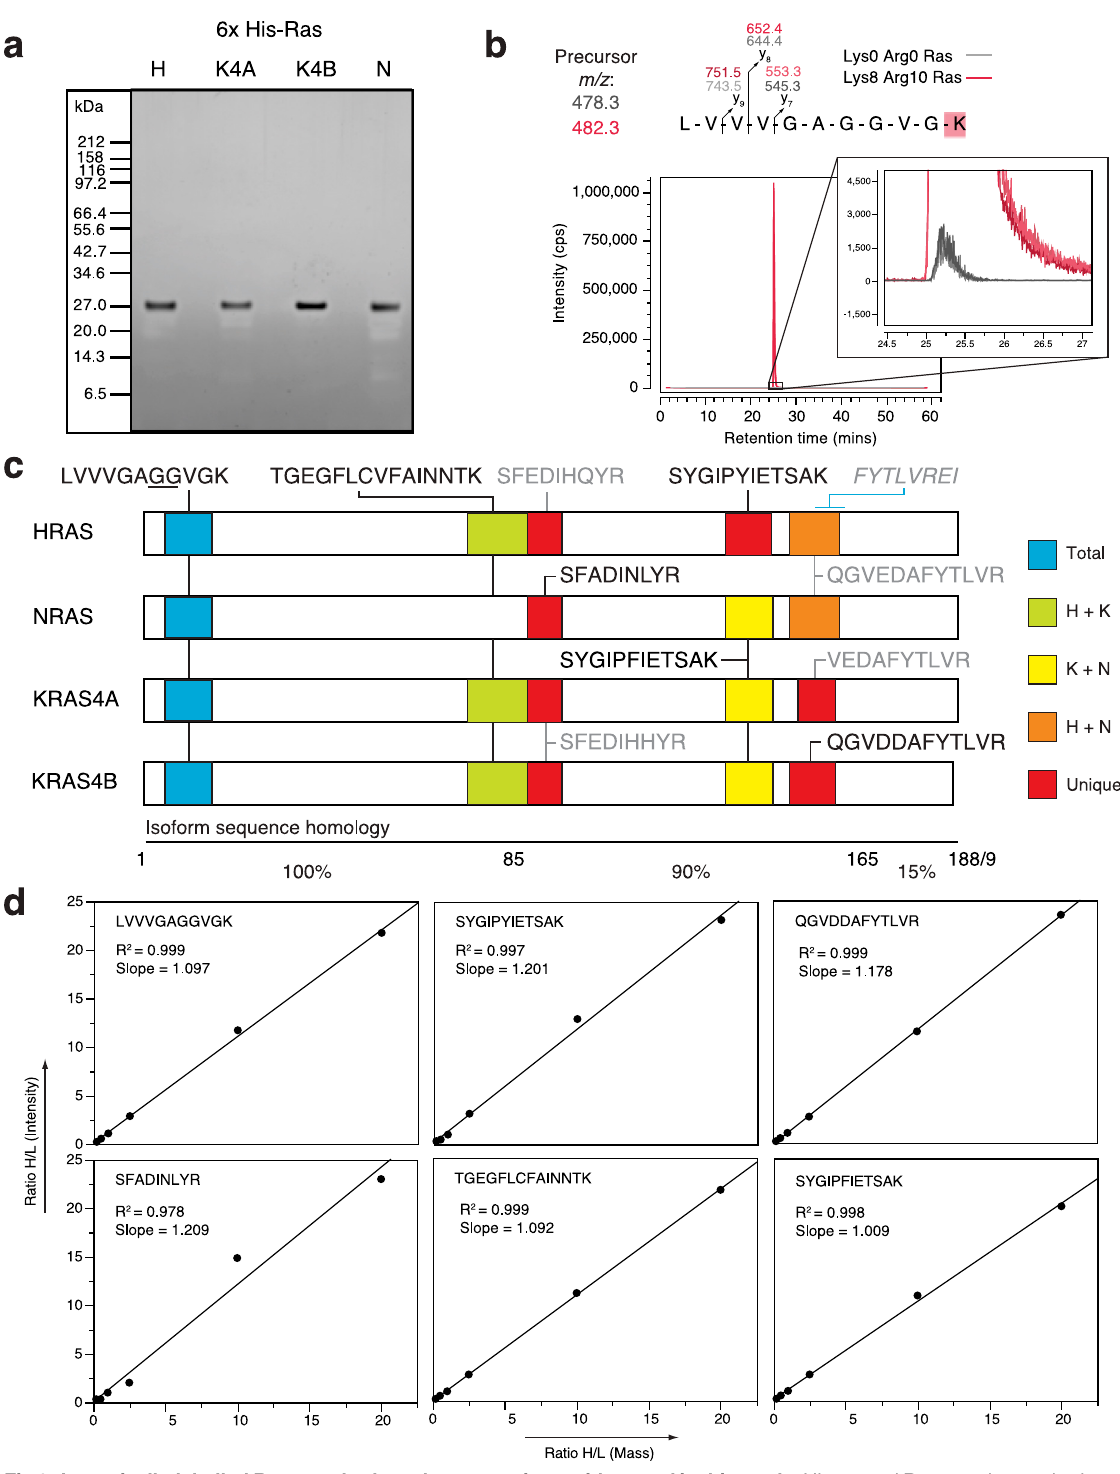
Fig 2. Isotopically-labelled Ras standards and proteotypic peptides used in this study. His-tagged Ras protein standards are isolated to high purity (A) and exhibit > 99% incorporation of isotope label (B). (C) Ras peptides used for quantification. Peptides in black were utilised for quantification, while those in grey were identified but were unreliably detected/ undetectable at endogenous levels in SW48 cells. All peptides are tryptic, bar FYTLVREI that is elastase derived. Sites of common Ras oncogenic mutations at codons 12 and 13 are underlined. (D) A linear relationship is observed (R 2 > 0.97) between the abundance of the Ras peptides injected onto the mass spectrometer and the integrated intensity of transitions. Full-length, light and isotope-labelled Ras